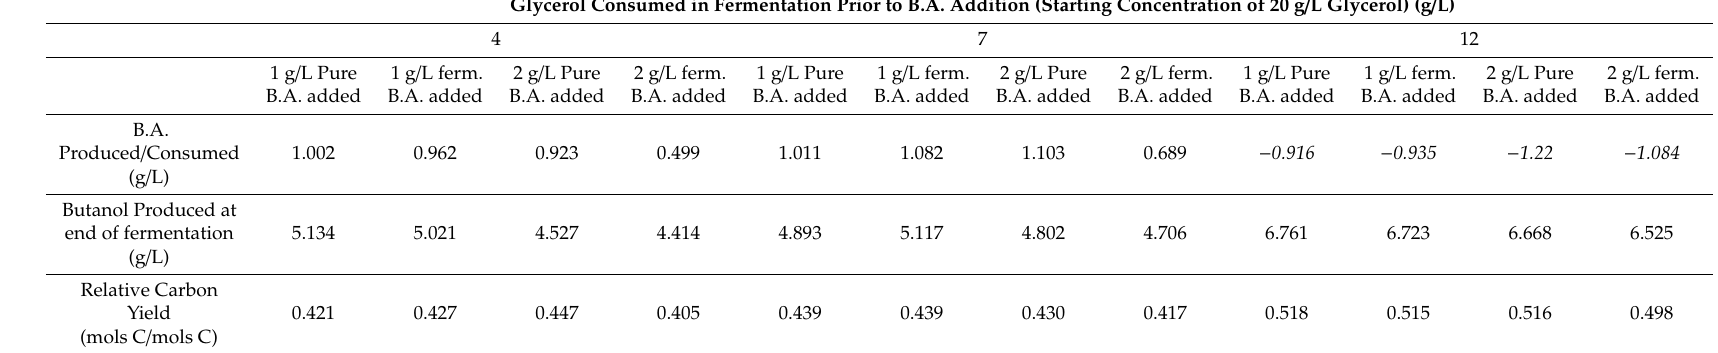
Table 1. Comparison of the butyric acid production / consumption, butanol production, and relative carbon yield following addition of butyric acid to fermentations at di ff erent points in the